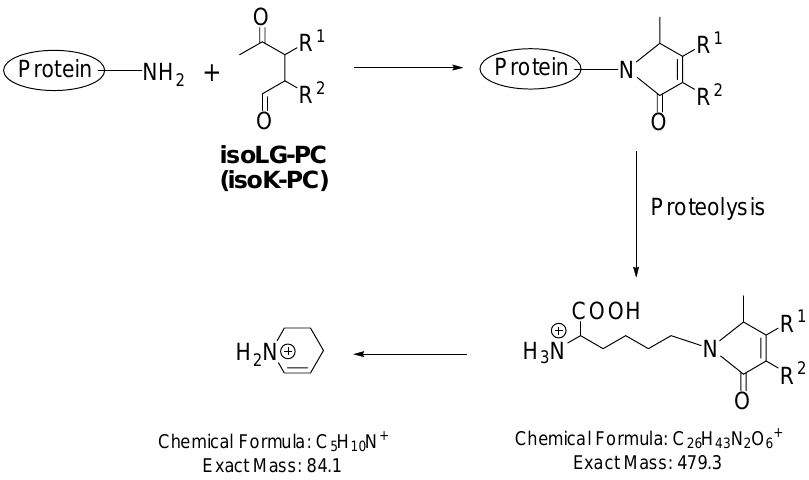
Scheme 4. MS/MS fragmentation of isolevuglandin-derived lysyl